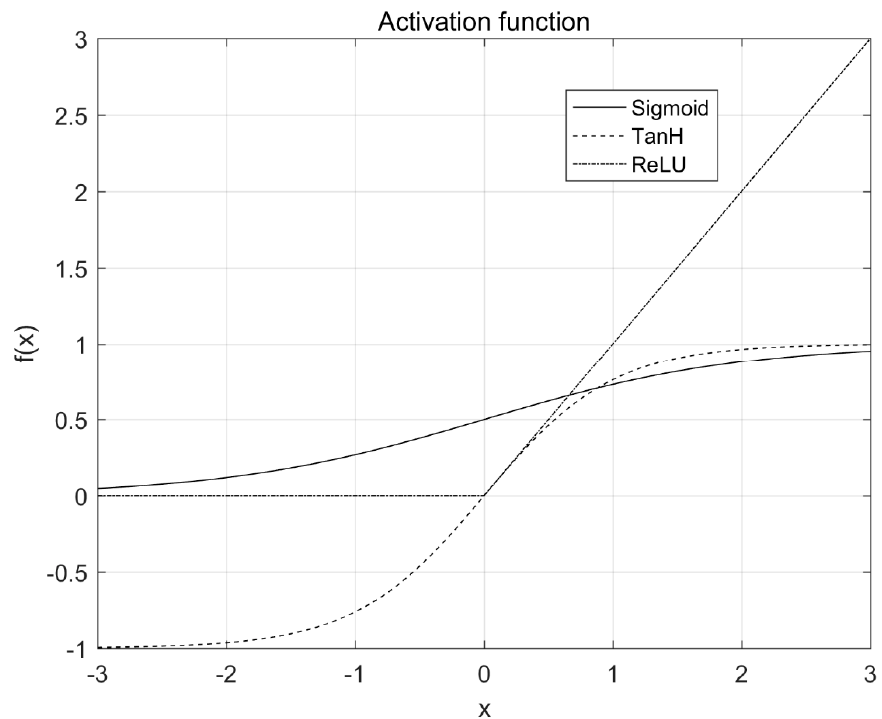
Figure 6. Activation functions.